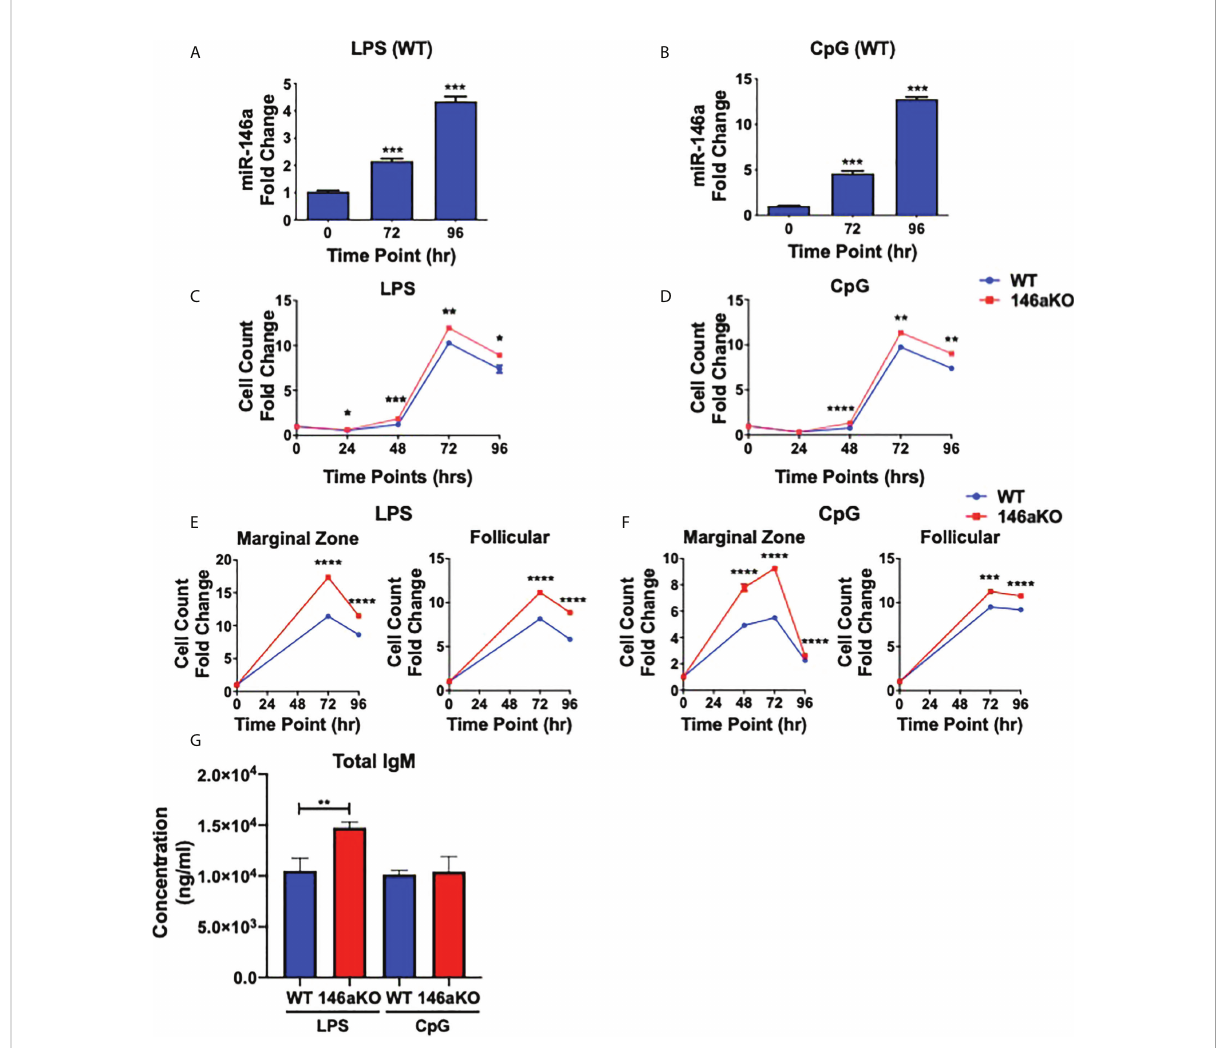
FIGURE 2 miR-146aKO B cells have higher in vitro response to T-independent antigens than WT and demonstrate increased antibody secretion in response to stimulation. (A, B) Stimulation of WT native splenic B-cells with (A) LPS or (B) CpG shows signi fi cant miR-146a induction at time points 72 and 96 hr (one-way ANOVA with Tukey ’ s multiple-comparisons test; *** P < 0.001). Graph combines three independent experiments. n = 3-4 mice/group/exp. Data represent mean ± SEM. (C and D) miR-146aKO splenic B-cells stimulated with (C) LPS or (D) CpG have higher cell counts than WT at various time points ( t test; * P < 0.05, ** P < 0.01, *** P < 0.001, **** P < 0.0001). Representative of 3-4 mice/group in triplicates, con fi rmed in at least six independent experiments. (E, F) miR-146aKO marginal zone and follicular B-cells show higher cell count than WT when stimulated with (E) LPS or (F) CpG ( t test; *** P < 0.001, **** P < 0.0001). Representative of three mice/group in triplicates, con fi rmed in three independent experiments. (G) Supernatants from in vitro stimulation at 72hr show higher total IgM secretion in miR-146aKO B cells compared to